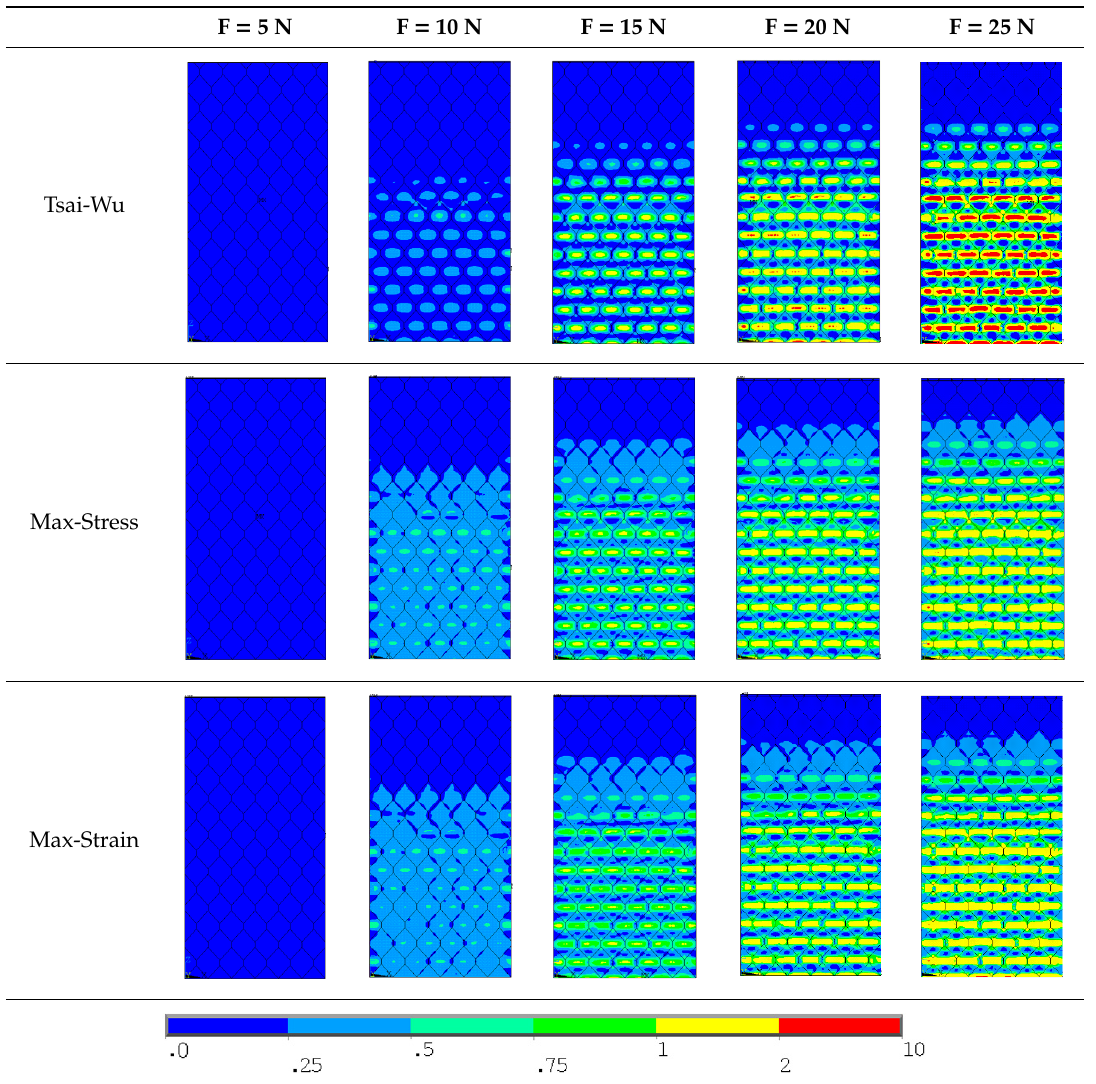
Table 8. Maps of criteria index for Model 1.2 CD R.